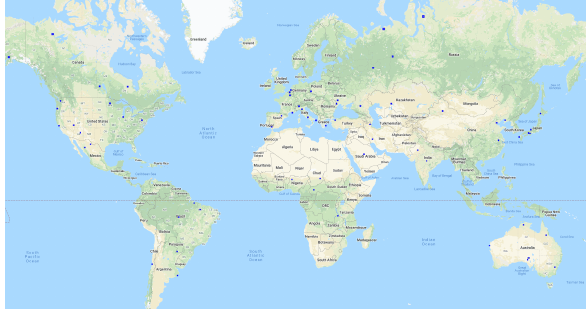
Figure 3. Visualization of locations of images in the experiment. Blue dots denote the location of clusters of smaller images.